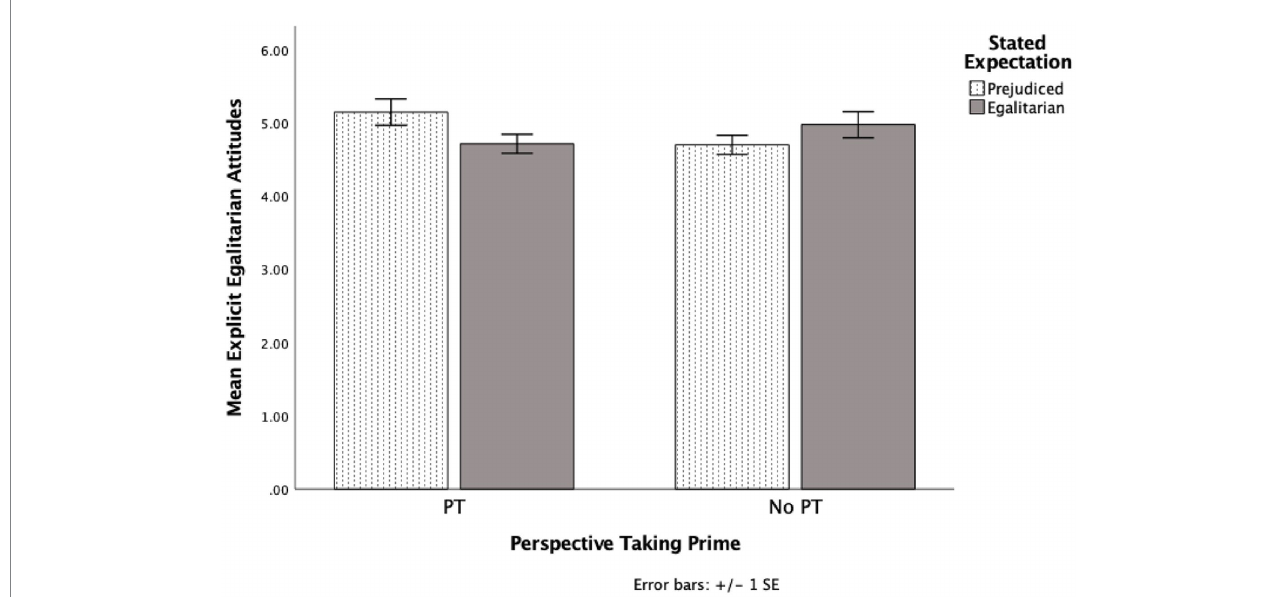
FIGURE 2 The effects of perspective taking and stated expectations on explicit attitudes toward Black individuals in Experiment